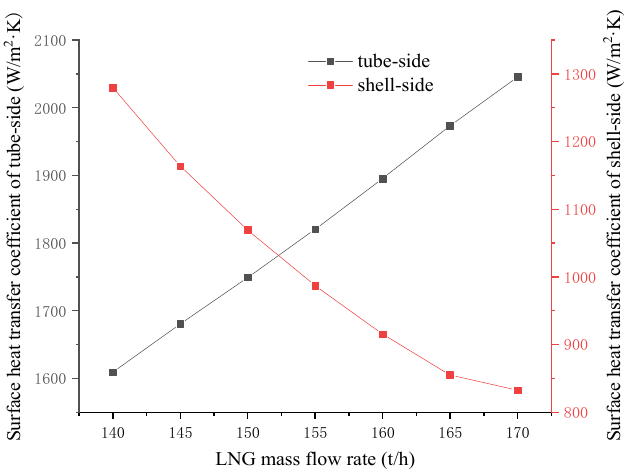
Figure 8. Surface heat transfer coefficient at different LNG mass flow rates.